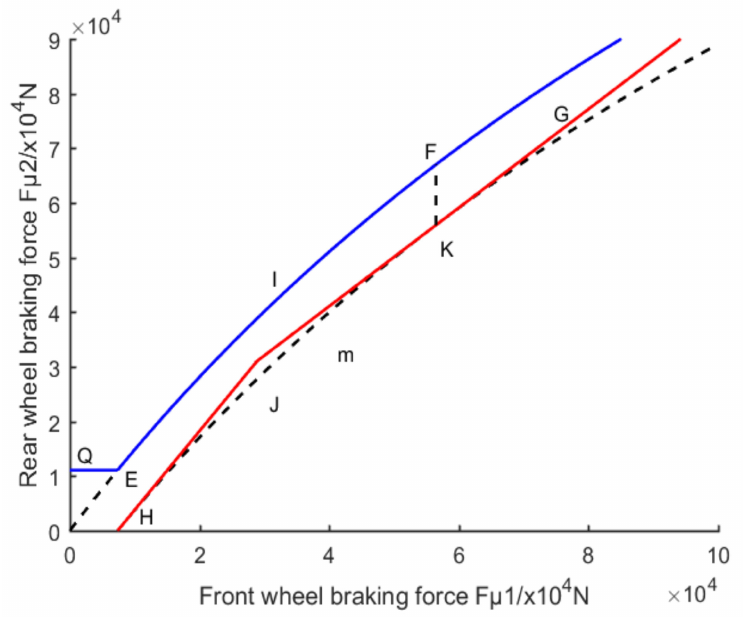
Figure 2. Parallel regenerative braking force distribution curve, based on the full utilization of motor